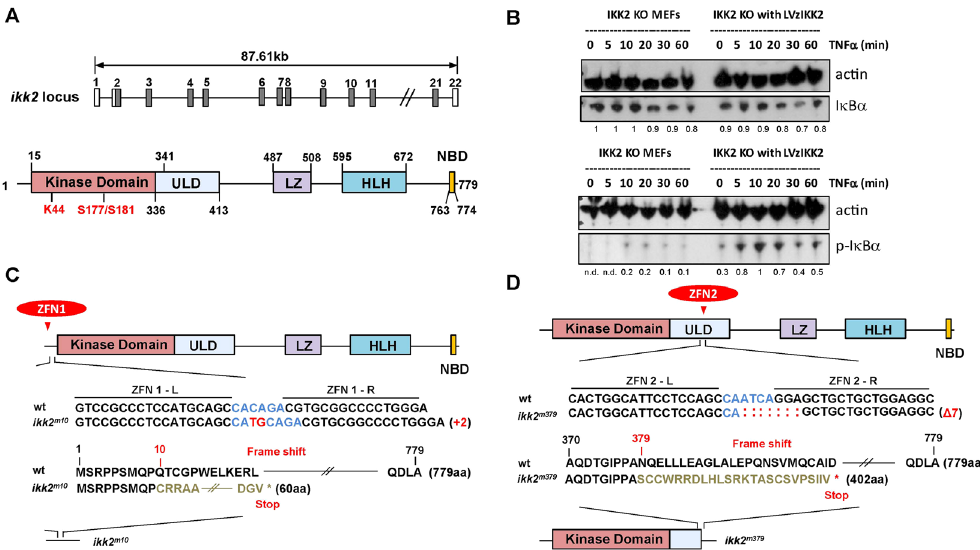
Figure 1. The two alleles of zebrafish ikk2 ( ikbkb ) mutant made using zinc-finger nuclease (ZFN)-mediated mutagenesis. ( A ) Genomic organization of the zebrafish ikk2 locus. It contains 22 exons (numbered). The domain organization of a putative Ikk2 of 779 aa derived by homology comparison with human IKK2. Numbers define amino acid residues. Abbreviations: ULD – ubiquitin-like domain; LZ - leucine zipper; HLH - helix- loop-helix domain; and NBD - NEMO-binding domain. The critical amino acid residues conserved in evolution are shown in red. ( B ) Zebrafish Ikk2 restored phosphorylation of murine I κ B α in IKK2 − / − immortalized MEFs upon treatment with TNF α for the indicated time period. Actin was used as loading control. Band intensities were quantified by densitometry in ImageJ and normalized to the most intensive band for each target. n.d., not detected. Data are representative of three experiments. ( C ) The first ZFN-mutation upstream of the kinase domain ( ikk2 m10 ) caused an indel mutant with a frame shift from 10 aa onwards and a truncated polypeptide of 60 aa. ( D ) The second ZFN-mutation designed within the ubiquitin-like domain ( ikk2 m379 ) caused an indel mutant with a frame shift from 379 aa onwards and a truncated polypeptide of 402